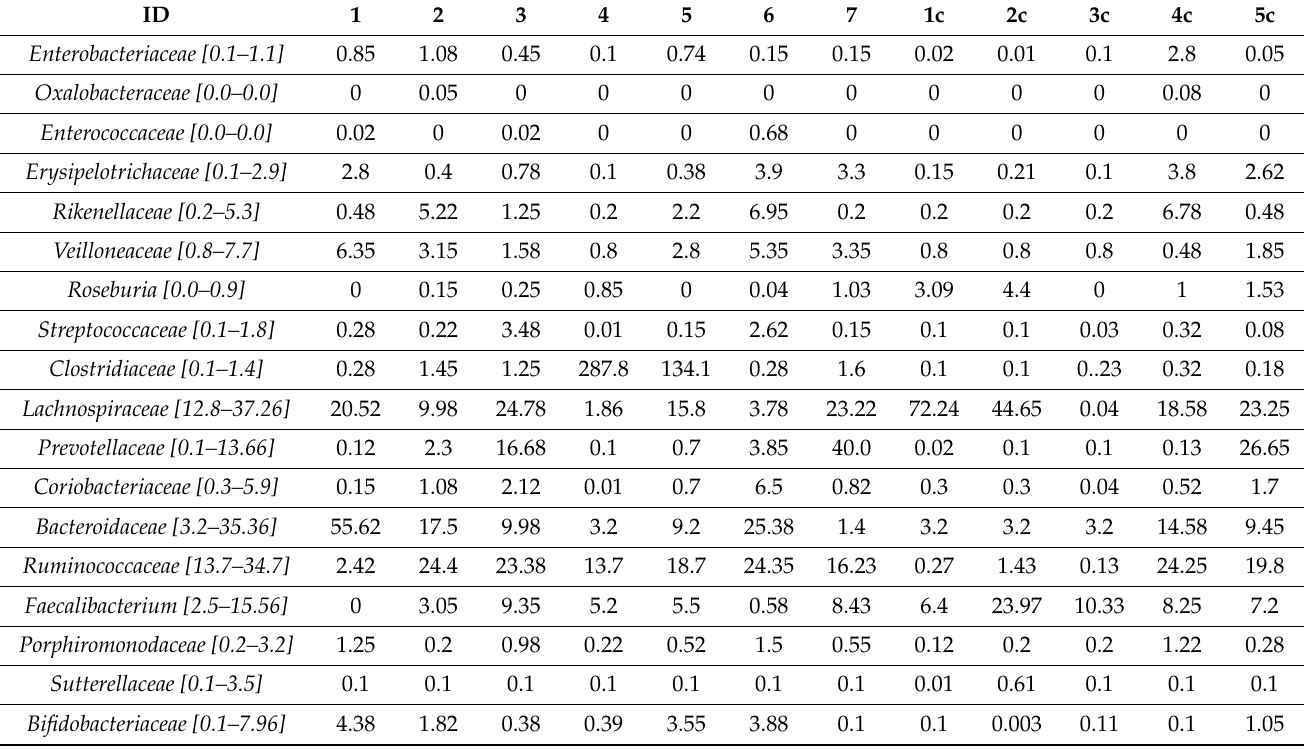
Table 2. Differentially represented bacterial families/genera in TMAU psychiatric cases and controls. Microbiota analysis of TMAU psychiatric cases and controls showed alterations (% relative abundance) for 16 families and 2 genera (Roseburia and Faecalibacterium). Over-representation are highlighted in red, down-representation in light blue. The normal range of % relative abundance is indicated between squared